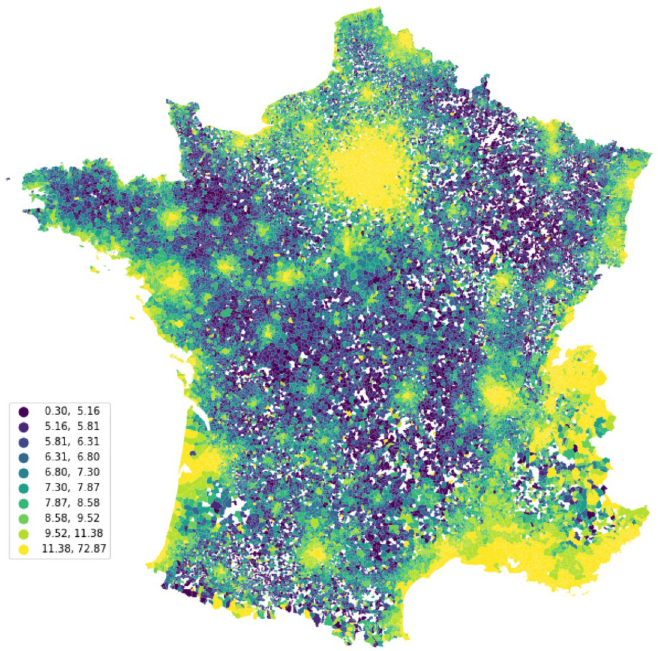
Fig 1. Average gross rent in French municipalities. Note: Author’s computations and ADMIN EXPRESS COMMUNE which is under an Open Licence Etalab https://www.data.gouv.fr/fr/datasets/admin-express/.